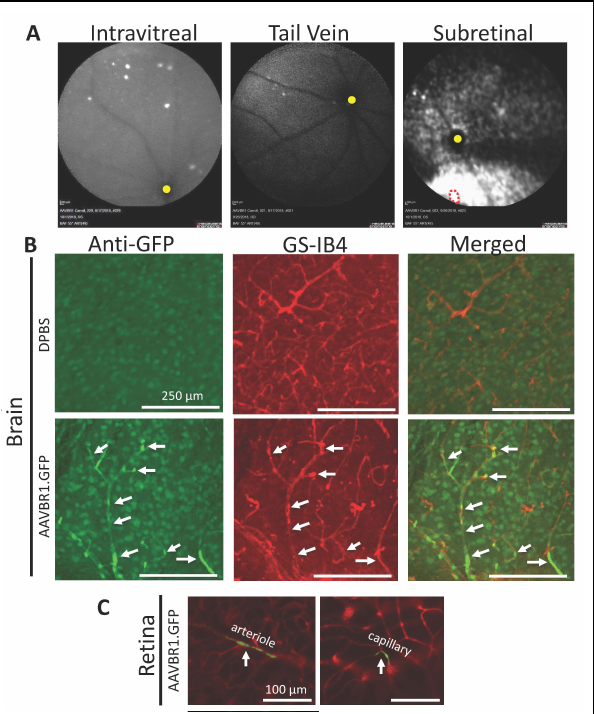
Figure 1. Fundus AAVBR1 expression depends on delivery route. ( A ). Fundus images one month after injection of AAVBR1.GFP. Intravitreal and systemic delivery show minimal retinal GFP fluorescence, whereas substantial signal is apparent following subretinal delivery. Optic disks are indicated by yellow dot. Subretinal injection site is indicated by dotted red line. ( B ). Colocalization of AAVBR1.GFP and GS-IB 4 signals in brain vasculature (white arrows) following systemic injection of AAVBR1.GFP, with only background autofluorescence seen in the brain of a systemic DPBS- injected mouse ( C ). Systemic injection yields only minimal signal in retinal vasculature, indicated by GFP/GS-IB 4